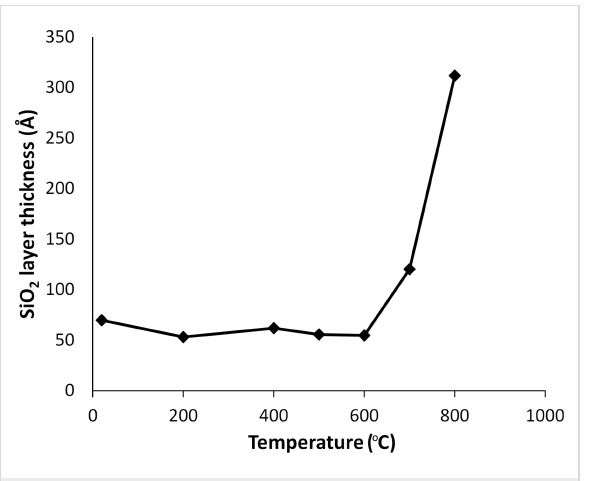
Figure 7: Evolution of the SiO 2 layer thickness as a function of the annealing